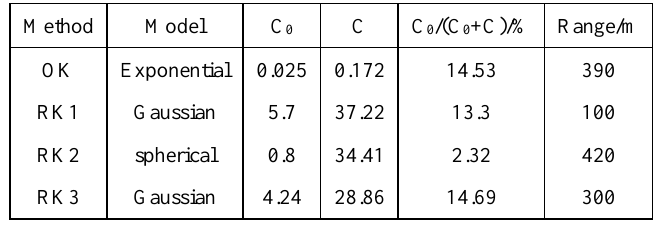
Table 5 Semi-variogram models for the SOC content